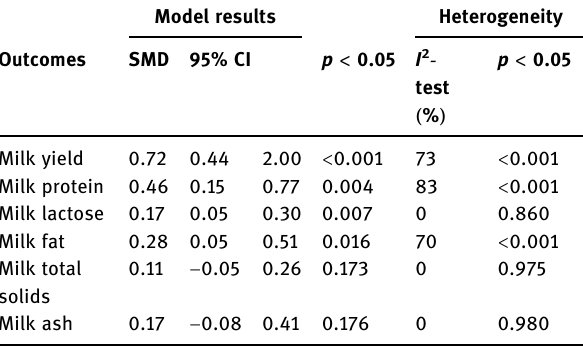
Table 2: E ff ect of SC on milk yield and components in